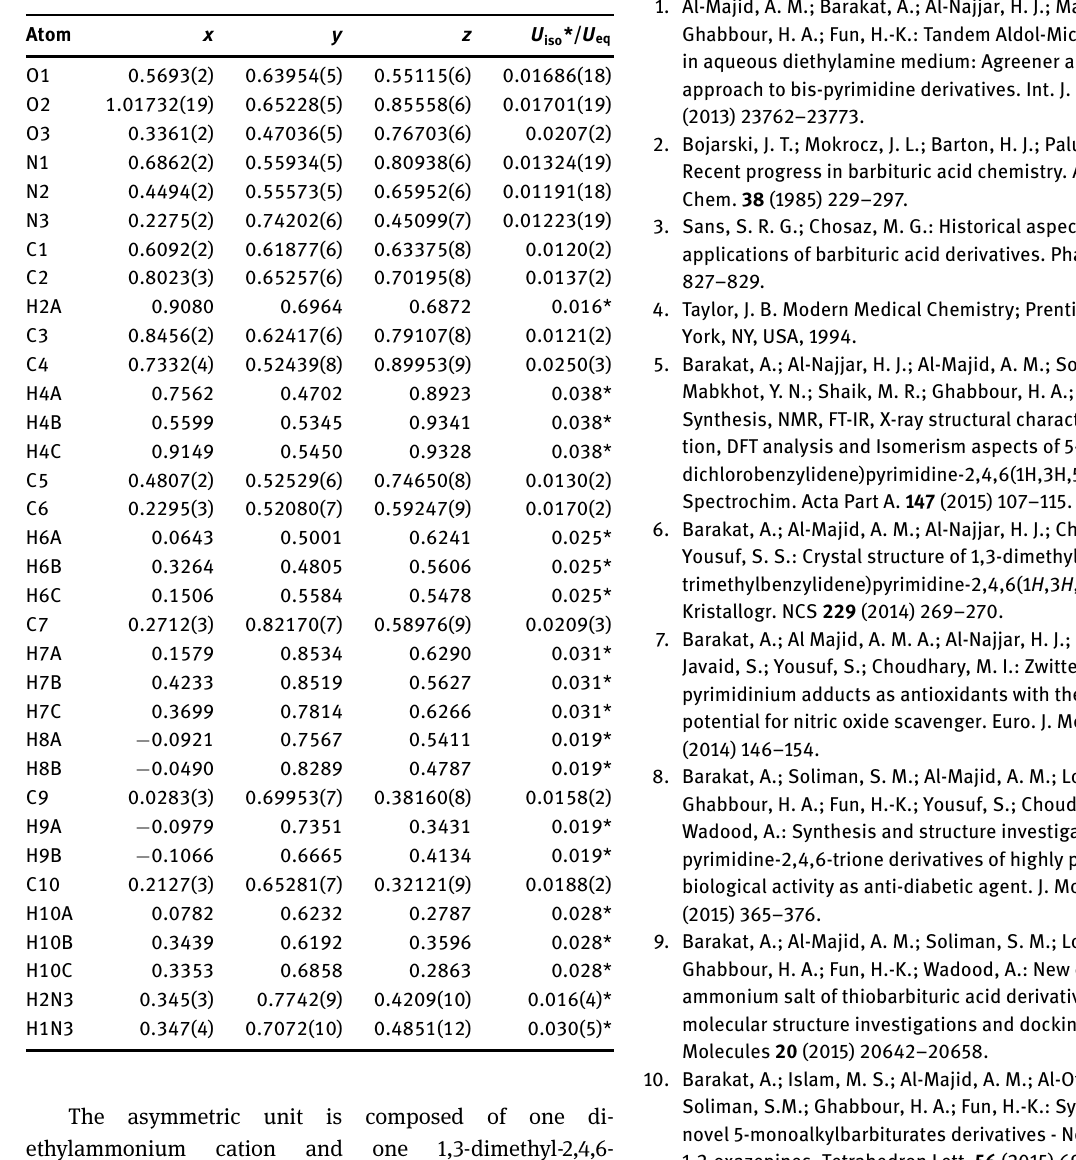
Table 2: Fractional atomic coordinates and isotropic or equivalent isotropic displacement parameters (Å 2